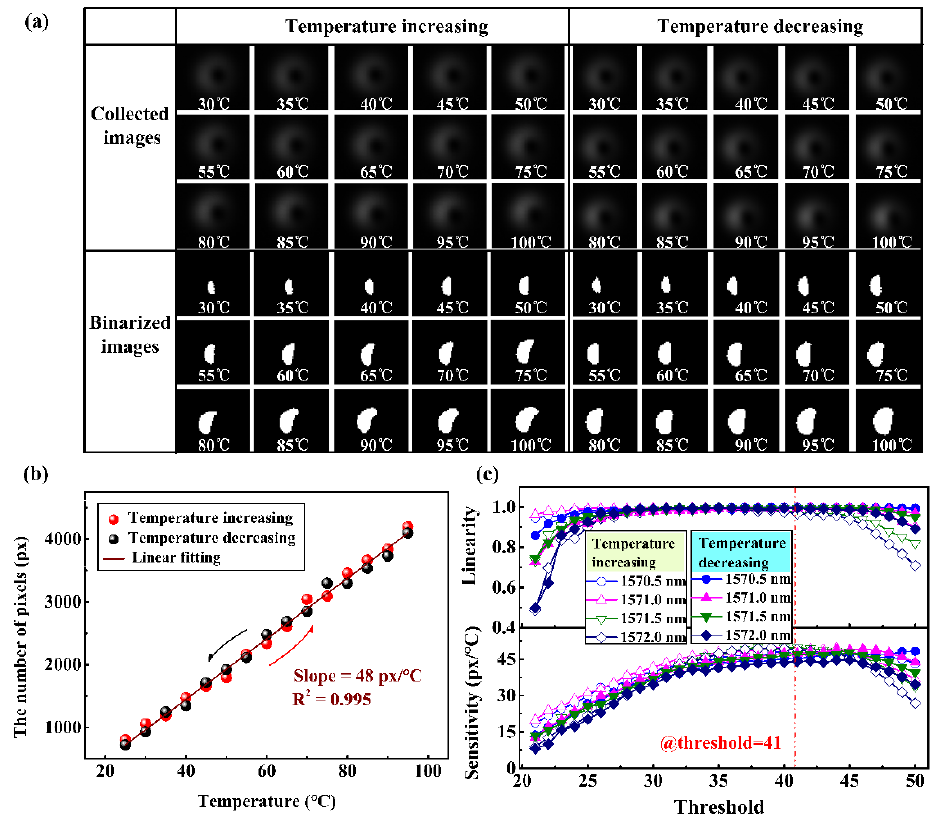
Figure 5. Experimental measurement results. ( a – c ) Experiment data with imaging area 7.83 mm 2 with temperature increasing and decreasing: ( a ) the collected and binarized images of the intensity distributions from 30 °C to 100 °C at 1571 nm; ( b ) experiment data of the temperature test and its linear fitting; ( c ) the evolution of sensitivity and linearity with different operation wavelength and threshold.